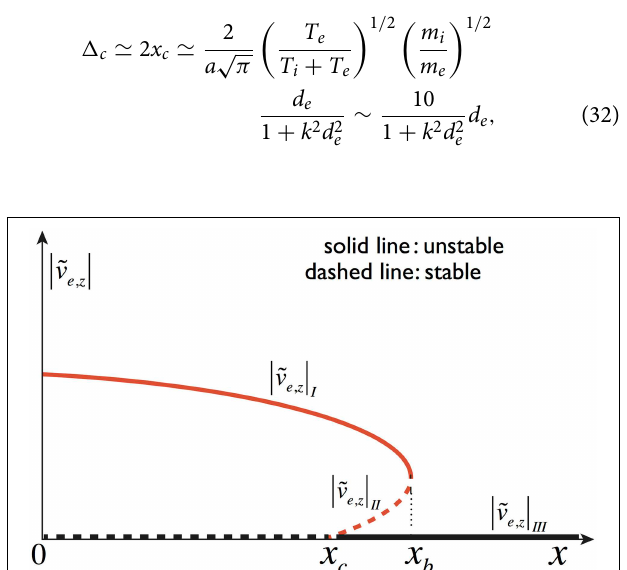
FIGURE 3 | Bifurcation diagram: solid lines represent unstable points, and dashed lines represent stable points. The red lines represents the solutions, and , and black line represents the solution, v e , z v e , z |˜ |˜ | I | II